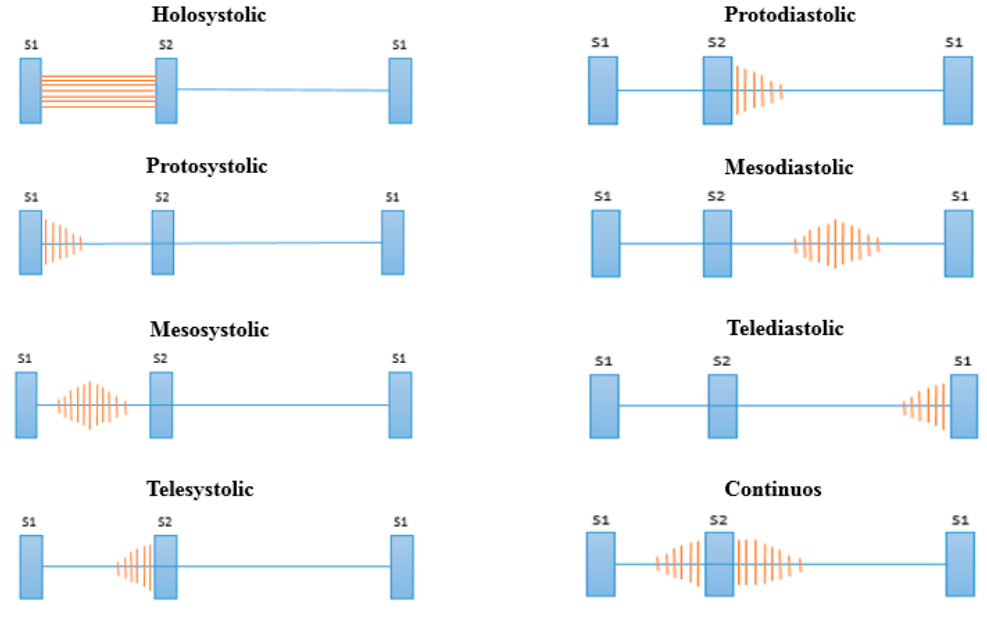
Figure 5. Types of murmurs according to their location. 301